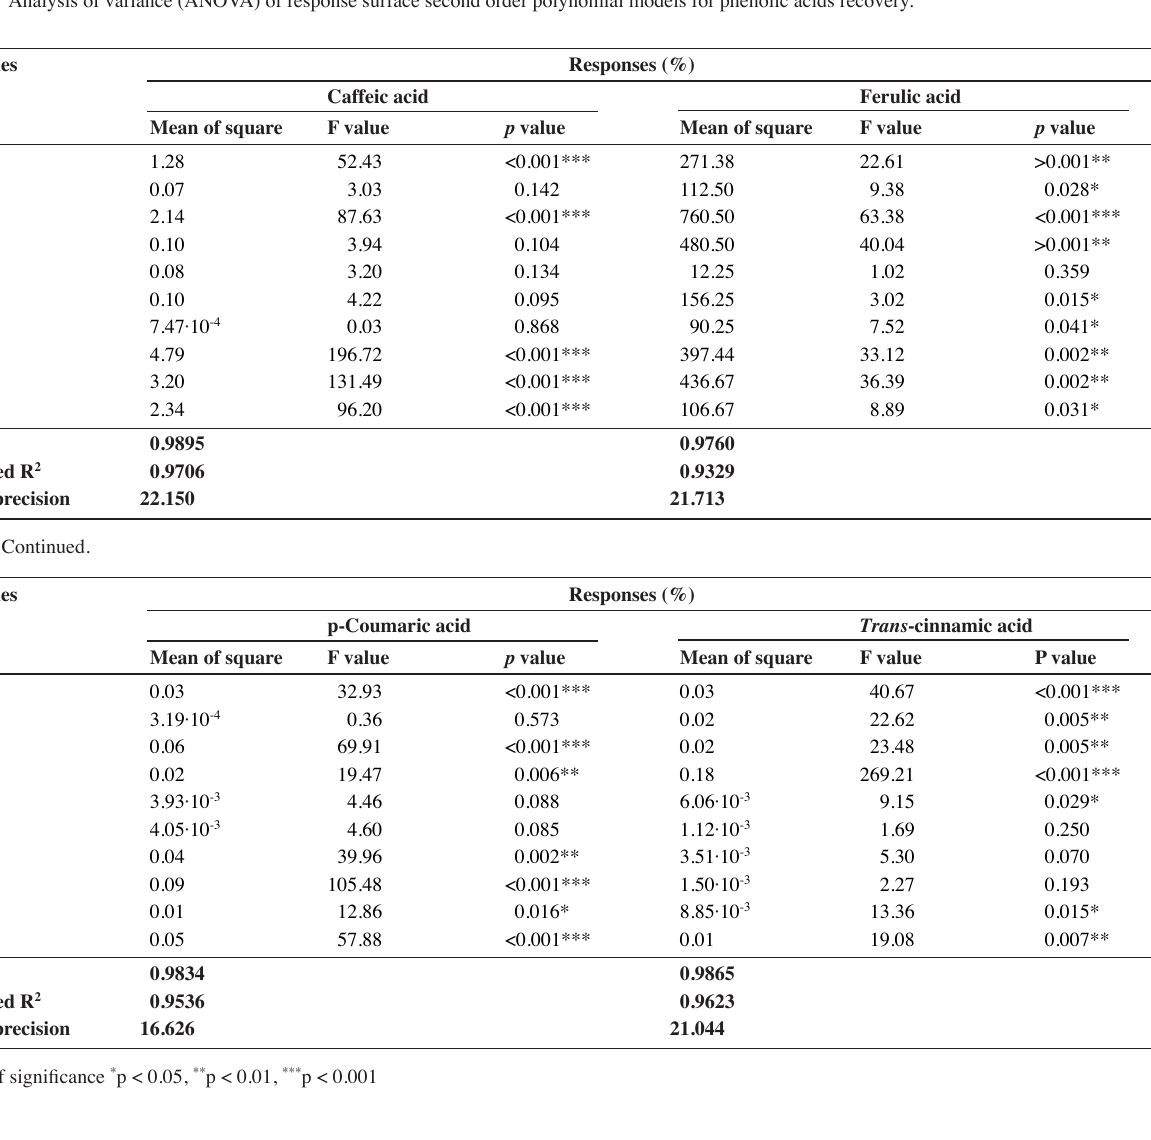
Tab. 4: Analysis of variance (ANOVA) of response surface second order polynomial models for phenolic acids